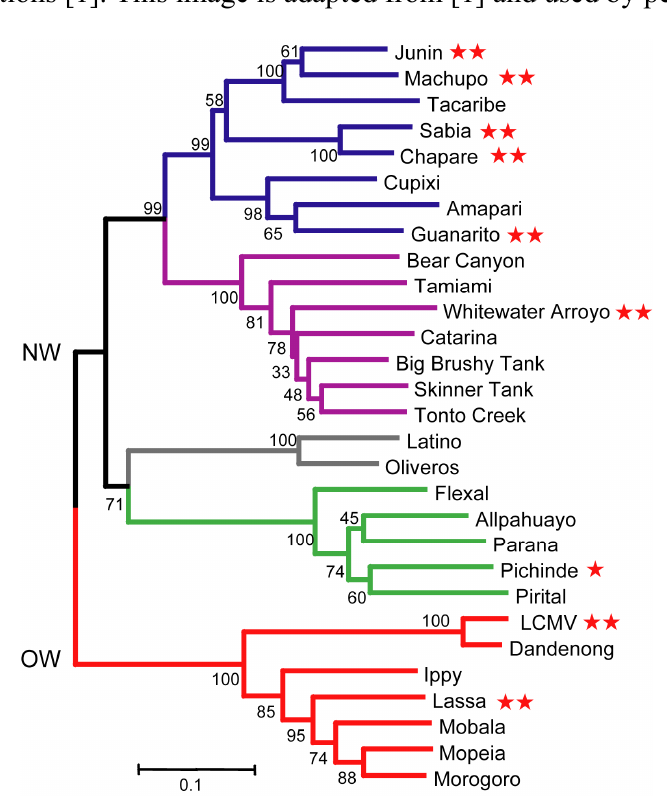
Figure 1. Phylogenetic relationships between arenaviruses. The Old World (OW) virus lineage is depicted in red, and New World (NW) lineages are subdivided into clades: A (green), B (blue), C (gray) and a recombinant A-B lineage (purple). This phylogenetic tree is based on amino-acid comparisons of the GPC. Red stars that follow virus names indicate the ability to infect humans: ** denote lethal hemorrhagic fever viruses and lymphocytic choriomeningitis virus (LCMV), and * identifies infections with few or no clinical manifestations [1]. This image is adapted from [1] and used by